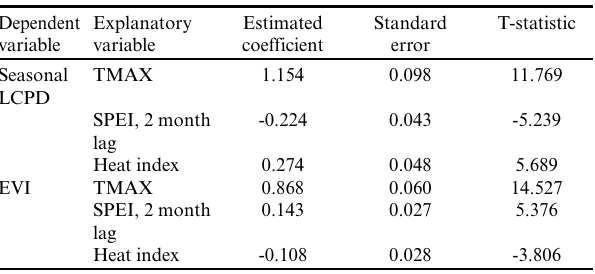
Table 1 . Standardized coefficients from generalized least square models of seasonal water use and urban greenness as a function of climate. p < 0.001 for all variables.